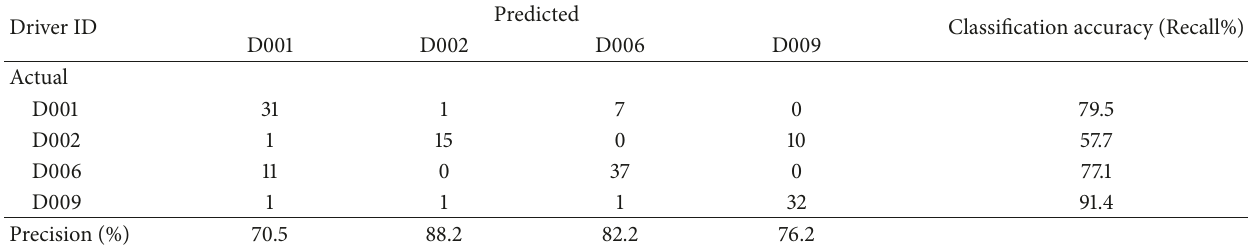
Table 3: Accuracy and confusion matrix on a group (G4) of drivers using global feature set.